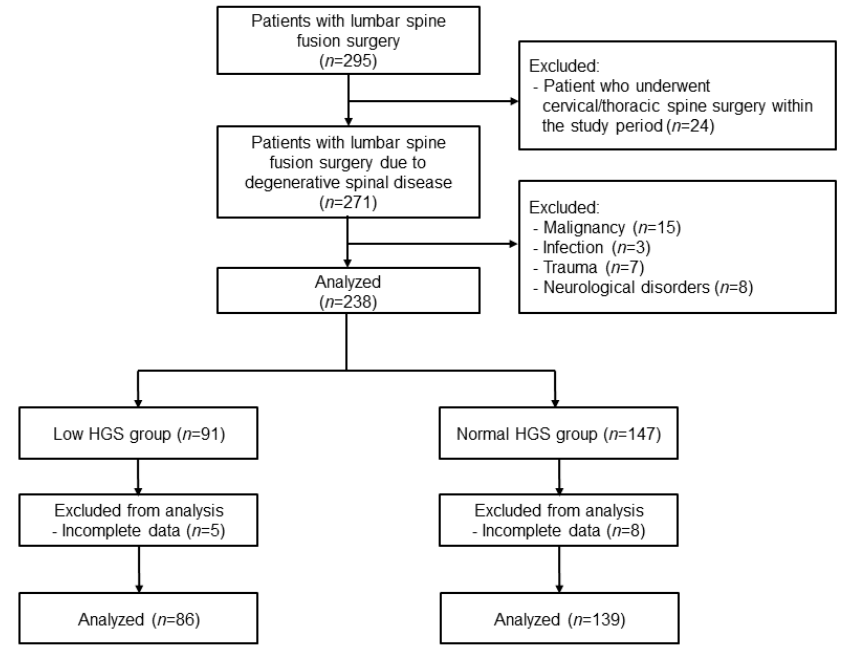
Figure 1. Flow diagram of the study. Figure 1 . Flow diagram of the study.